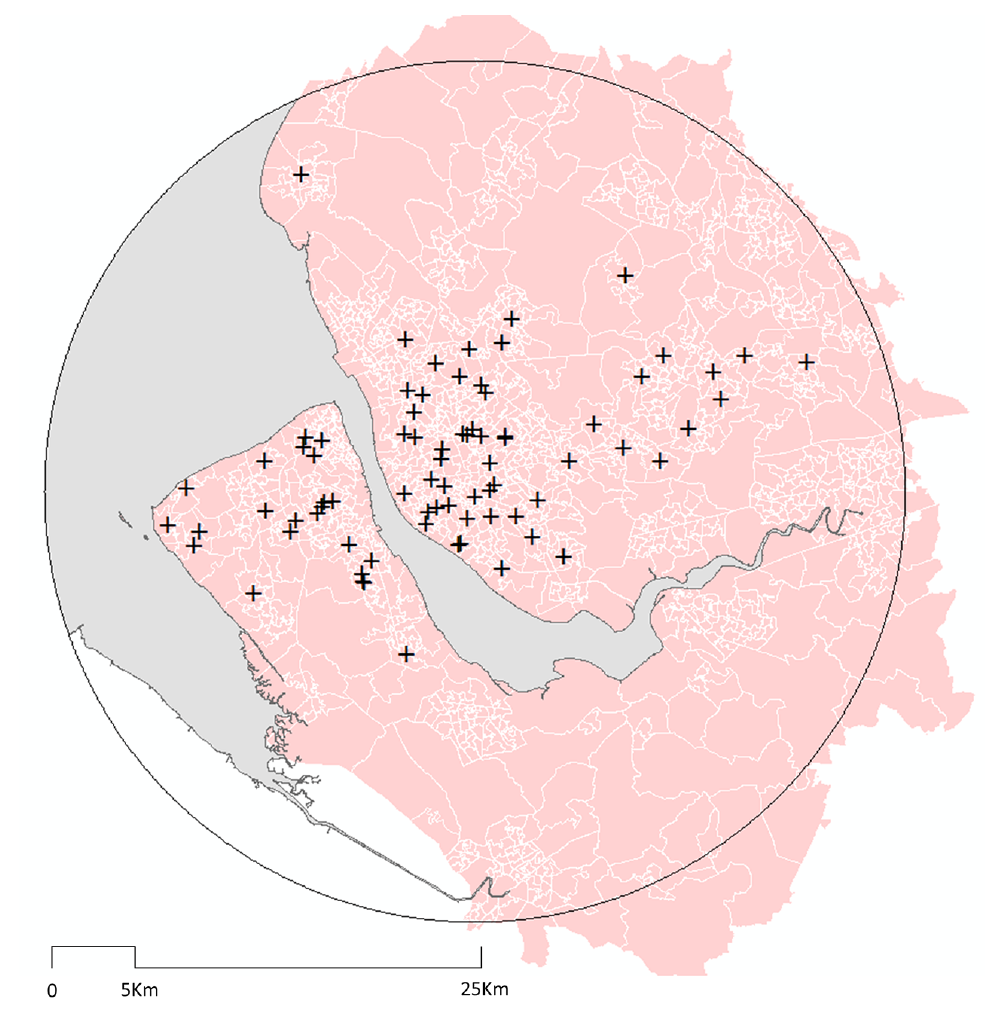
Figure 2. Distribution of the 77 secondary schools in the study area, over LSOA geography. ing of how people make use of spatial assets in their vicinities, in order to conceptualize their local commu- nity formations. In addition, the project sought to under-